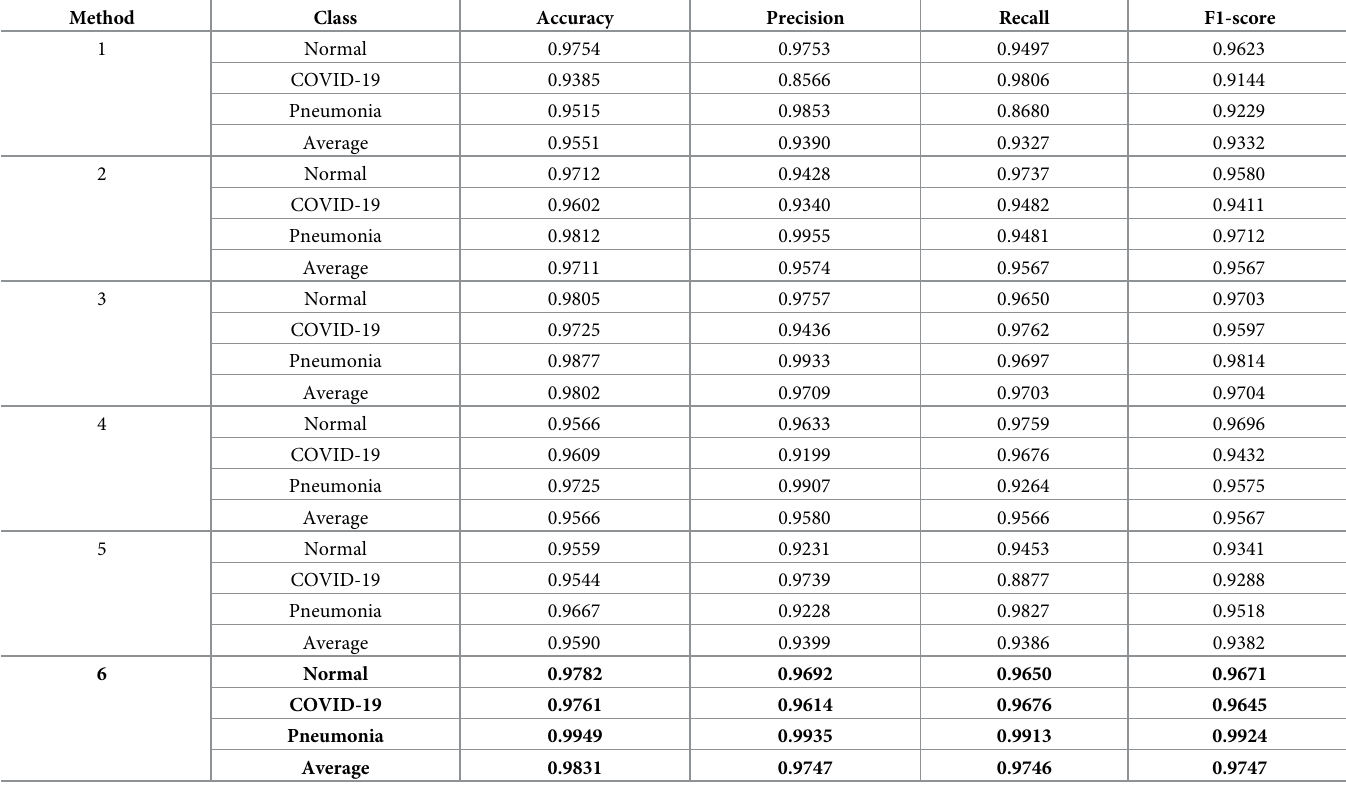
Table 2. Obtained results for different pre-processing methods: 1—none, 2—histogram equalization, 3—Gaussian blur + hist. equalization, 4—bilateral filter + hist. equalization, 5—adaptive masking, and 6—adaptive masking + Gauss. blur + hist. eq.